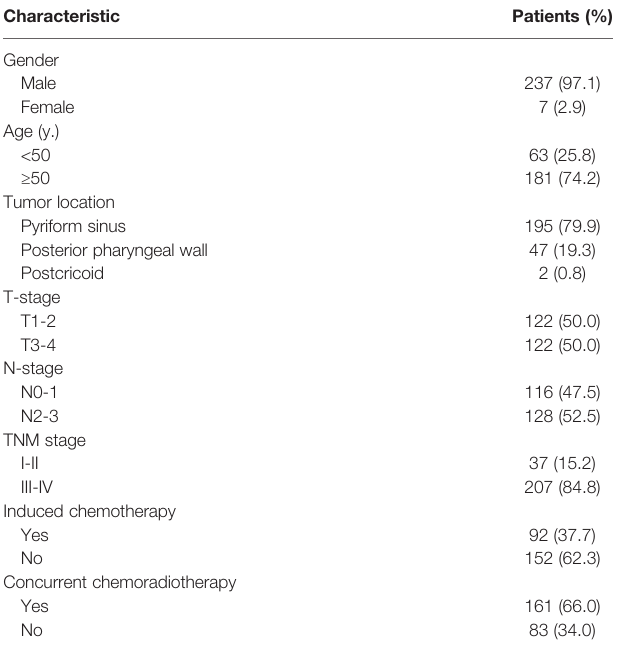
TABLE 1 | The baseline characteristics of the patients.